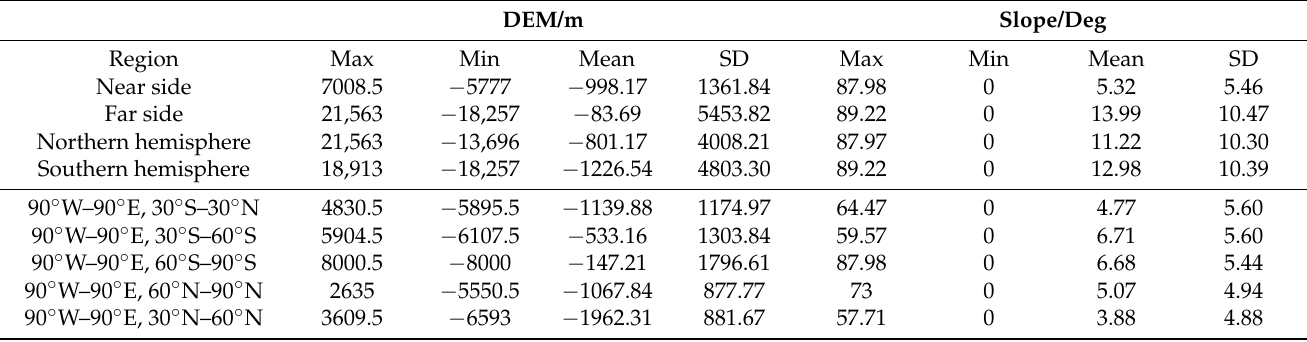
Table 1. The maximum (Max) value, minimum (Min) value, mean value, and standard deviation (SD) of DEM and slope on the near side, far side, northern hemisphere, and southern hemisphere, respectively.